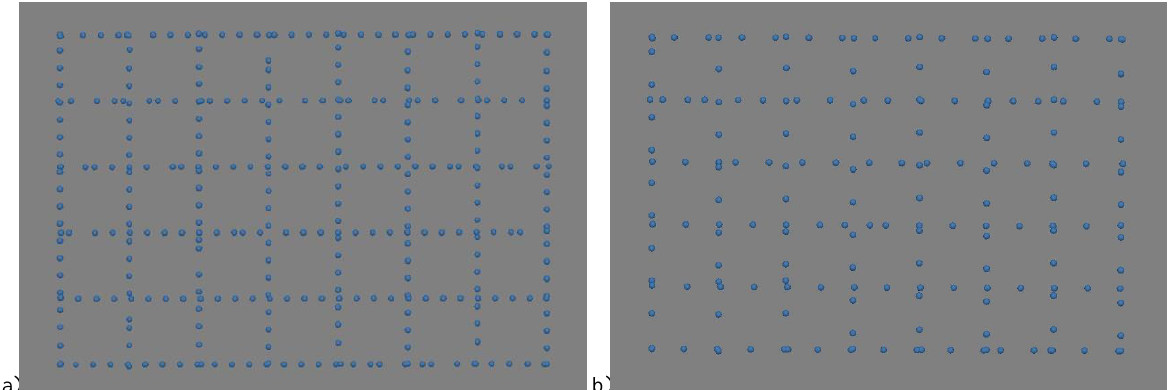
Figure 6. Image block of the single-grid flight before (a) after (b) filtration. An example of irregular overlap is shown.